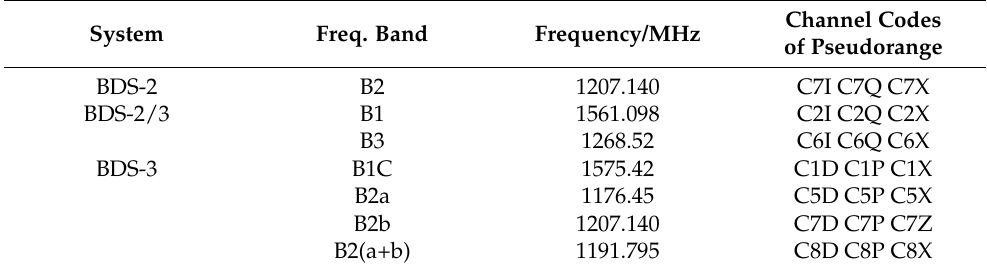
Table 1. The pseudorange channels of BDS multi-frequency signals. System Freq.